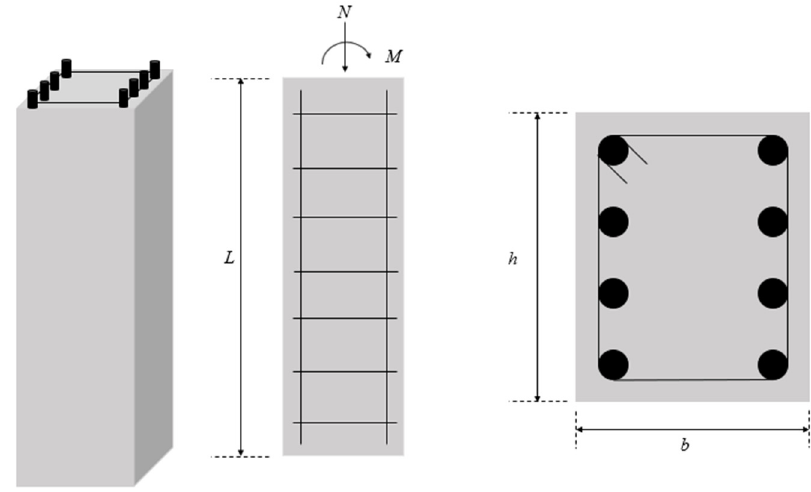
Figure 1. Geometry of the RC column.